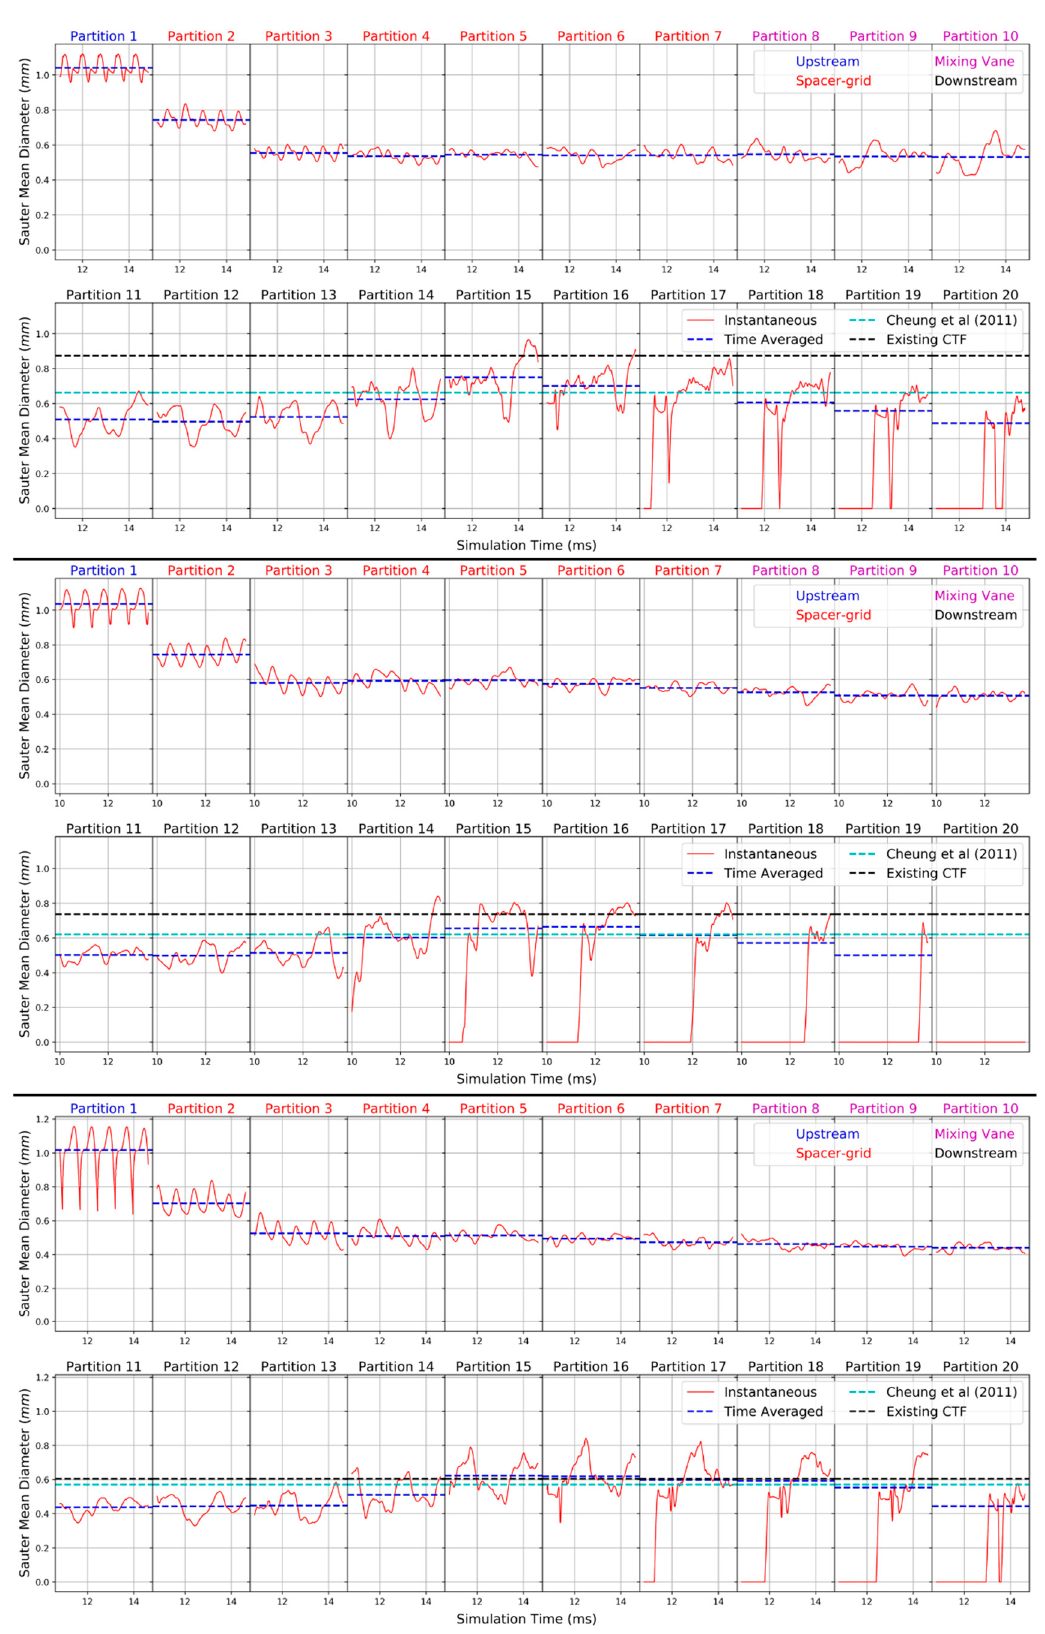
Figure 18. Axial evolution of Sauter mean diameter (SMD) in partitions for We40, We55 and We80 ( top – bottom ) water–steam system cases. For each case, the SMD value obtained from existing empirical correlations is also shown.